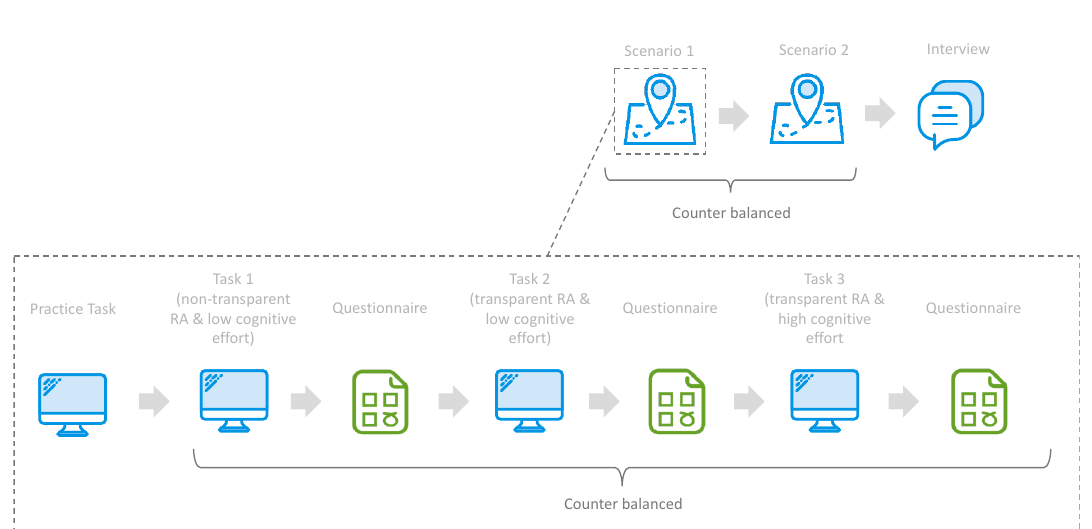
Figure 1. Experimental protocol.